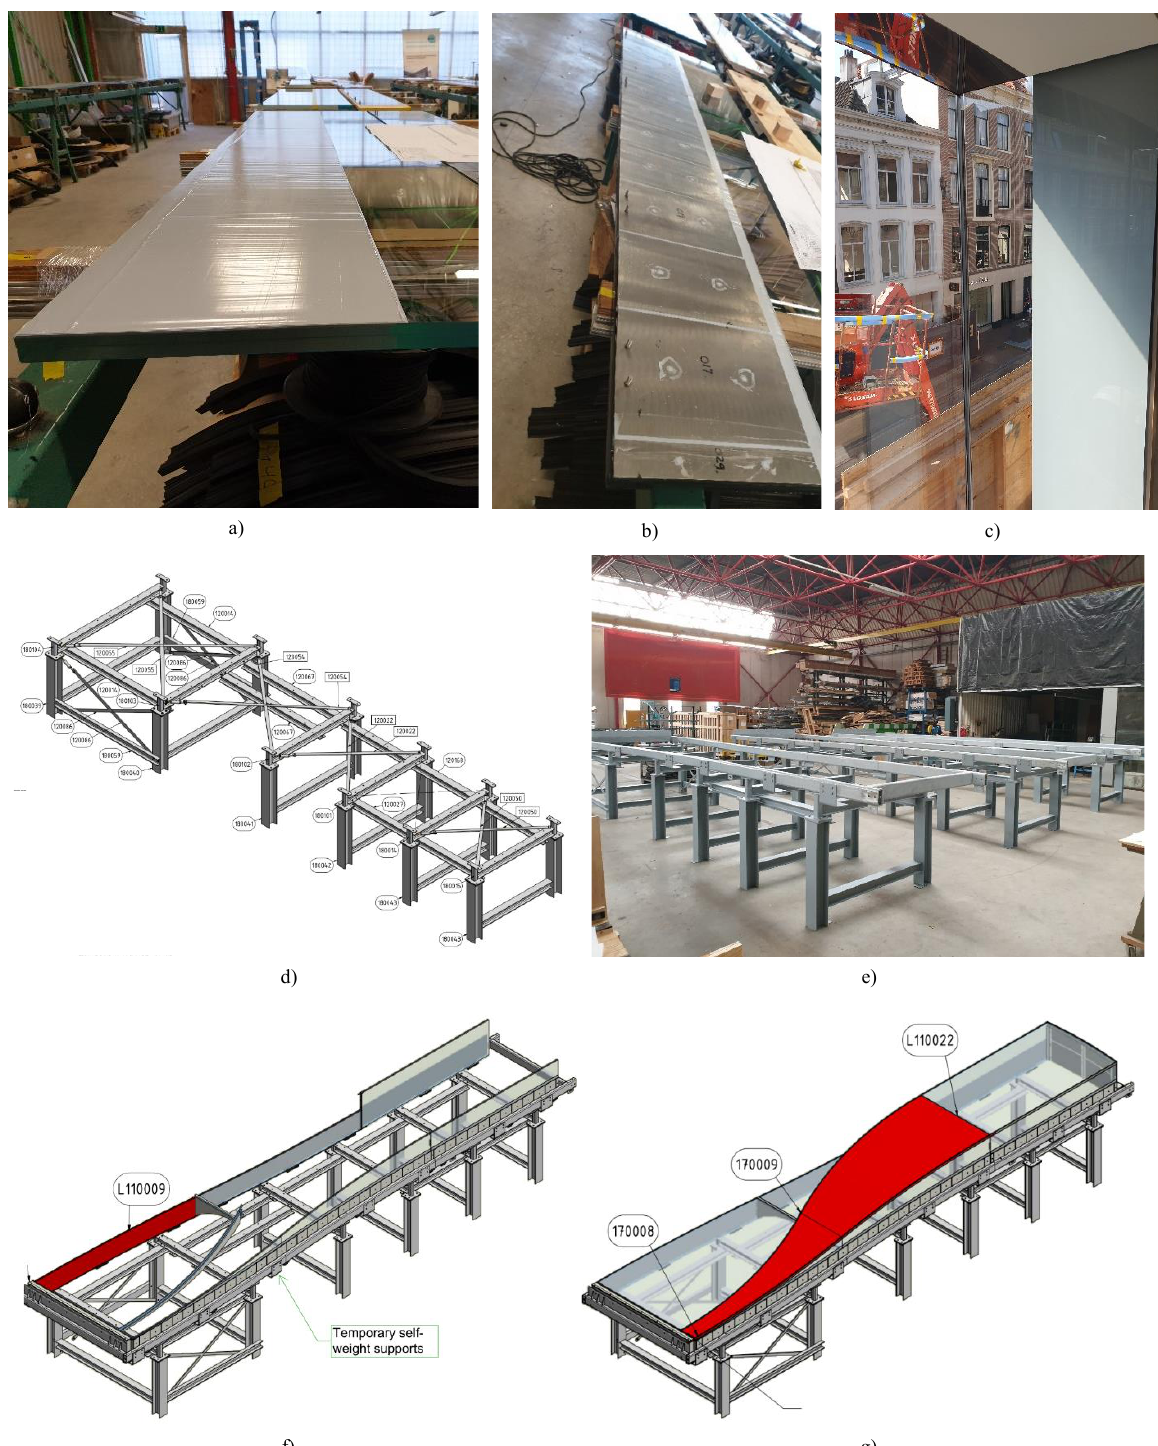
Fig. 14a) Light grey pre-smearing of a side pane (step a) in the workshop, b) Gluing of stainless steel cooling ribs to side glass, c) A view of the light grey pre-smearing of a side pane from inside after final assembly on site, d) Supporting structure (step d), e) Main structure in supporting structure (step e), f) Drawing of all glass side elements on temporary supporting structure with temporary supports to the main steel structure (step f), and g) Drawing of temporary supporting structure with all glass panes applied with highlighted front element (step